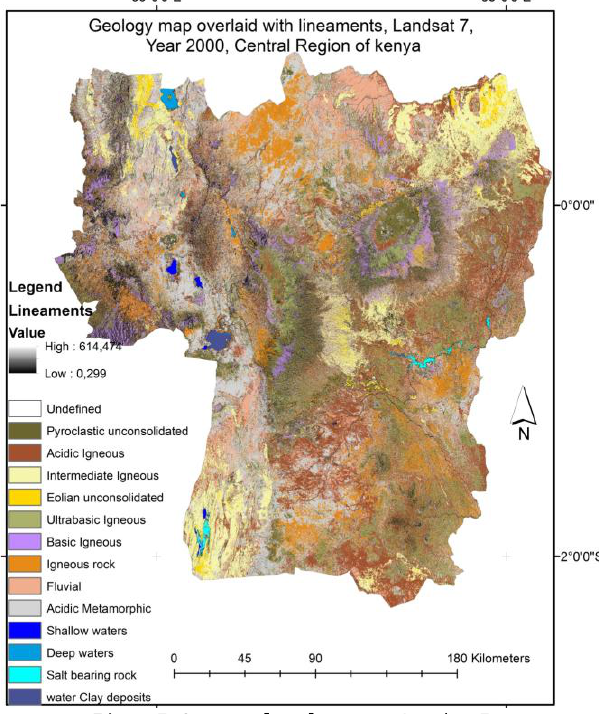
Figure 7: Structural geology map, Landsat 7